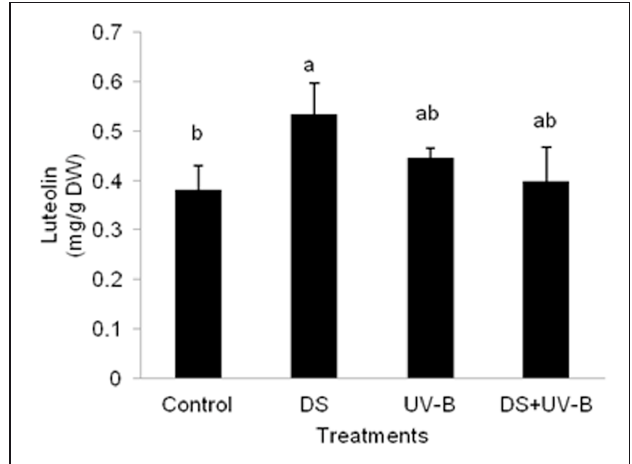
Fig. 6: Luteolin content (mg g -1 DM) of lettuce at harvest in response to drought stress, UV-B radiation and in combination of drought stress and UV-B radiation. Vertical bars represent standard deviation, and different letters indicate differences at the significance level p ≤ 0.05 (Tukey test). (Control = well-watered; DS = drought stress, i.e. water-deficit; UV-B = well-watered with UV-B radiation of 0.11 kJ m -2 ; DS+UV-B = drought stress i.e. water-deficit in combi- nation with